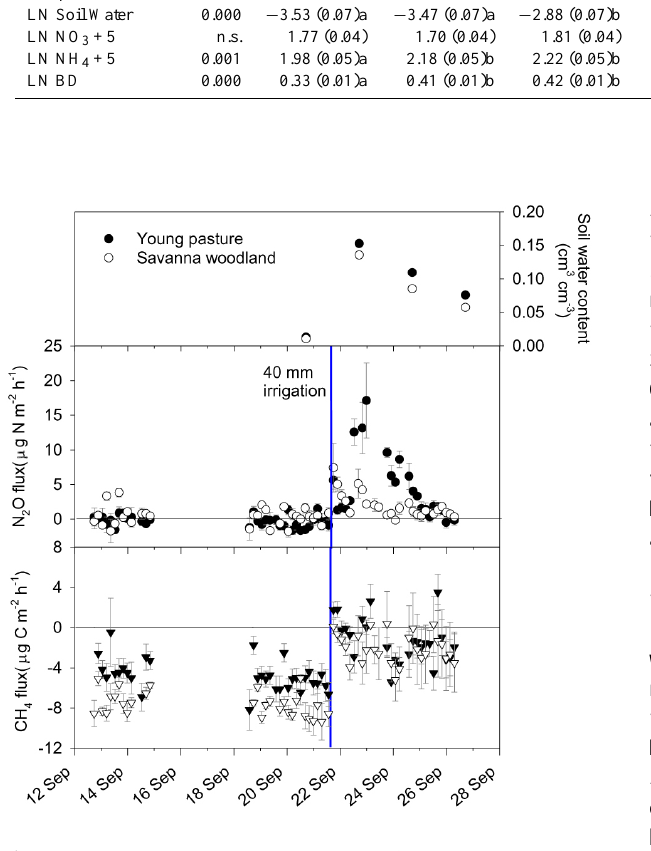
Fig. 4. Methane and nitrous oxide fluxes from soil in a savanna woodland (open symbols) and adjacent young pasture (closed sym- bols), before and after a 40mm irrigation event. Error bars are the standard errors from five replicate chambers. Soil water content was measured before and during the irrigation experiment (young pasture closed circles, savanna open